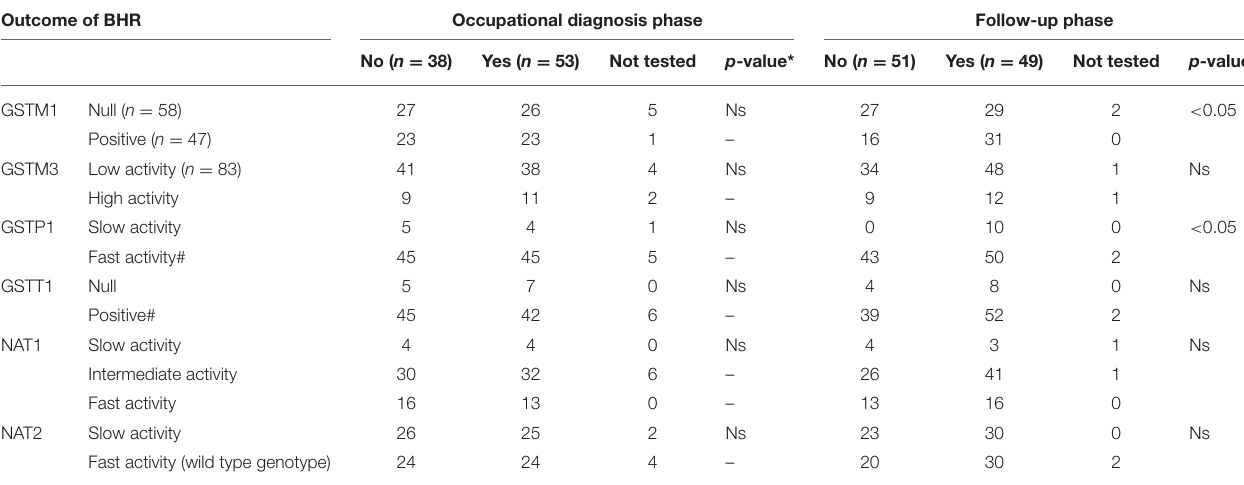
TABLE 3 | Cross-tabulation of GST and NAT enzymes with bronchial hyperreactivity. Outcome of BHR